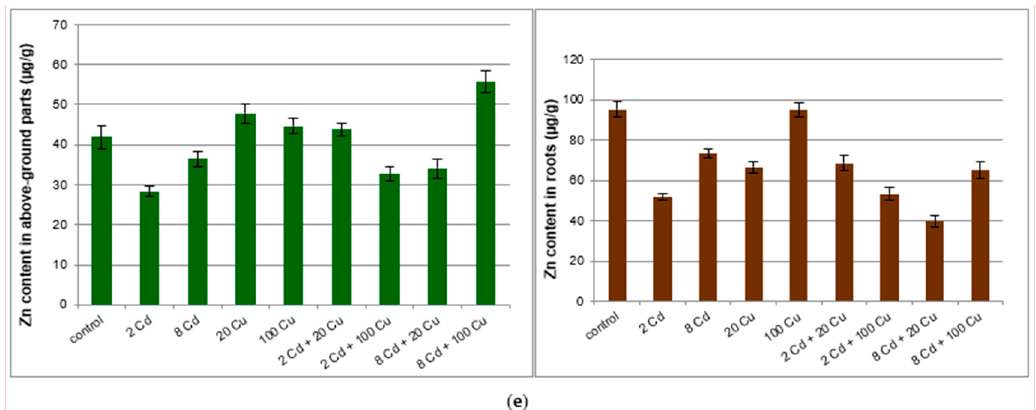
Figure 1. Manganese ( a ); lead ( b ); copper ( c ); cadmium ( d ); zinc ( e ) content (µg/g) in above ground parts and roots of the Melissa officinalis plant displayed against the Cd and Cu doses as used for the soil supplementation. 2 Cd = 2 µg/g cadmium; 8 Cd = 8 µg/g cadmium; 20 Cu = 20 µg/g copper; 100 Cu = 100 µg/g copper. In ( c ) and ( d ) dark bars show lower metal concentrations and are related to the left scale axis while pale bars (higher concentrations) are represented by the right axis.